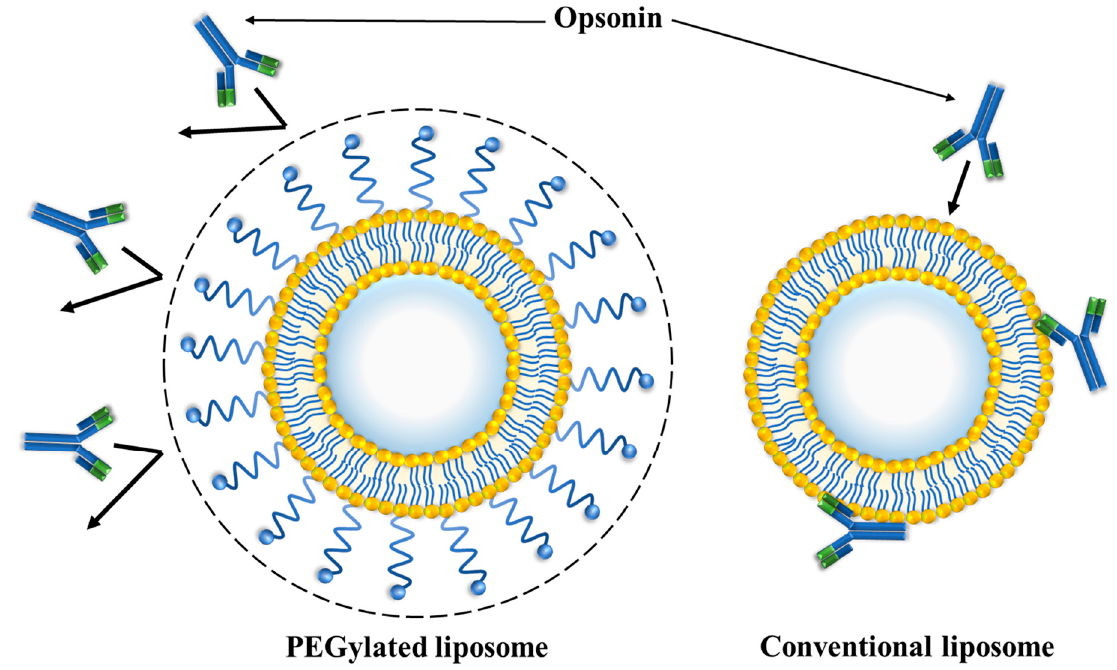
Figure 3. Comparison of PEGylated liposome with conventional liposome. PEGylated liposome: high molecular size, high solubility, and shielding against the recognition by opsonin. Conventional liposome: small molecular size, low solubility, and recognition by opsonin.